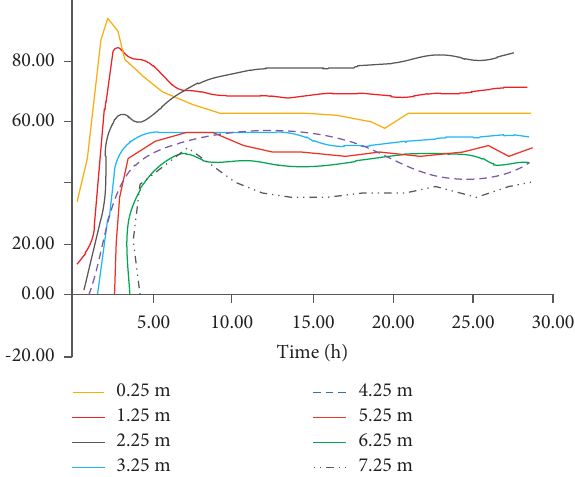
Figure 4: Curves of lateral